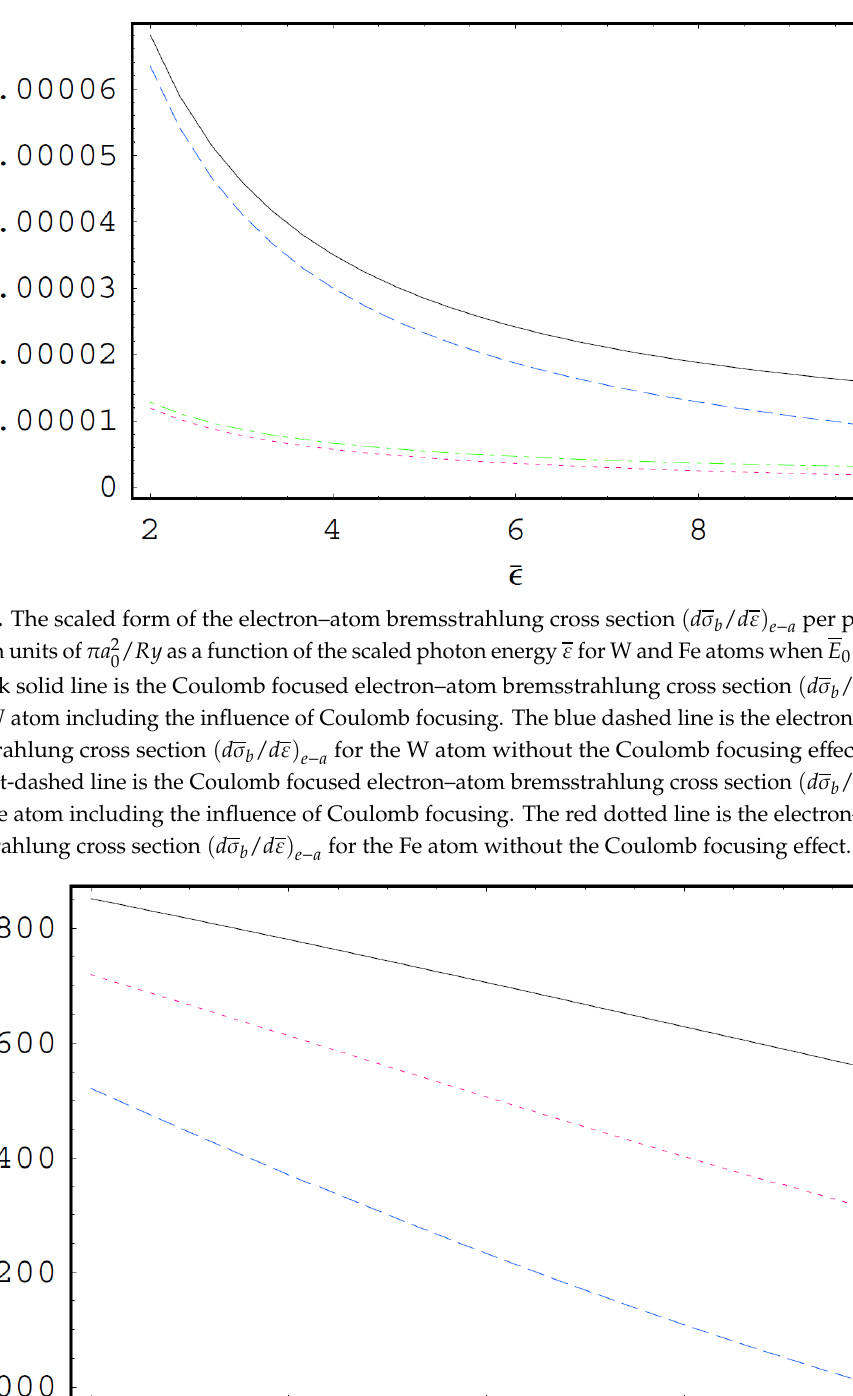
cn e n a ] as a function of [ (32 / 3 ) ] P r cn n π= as a